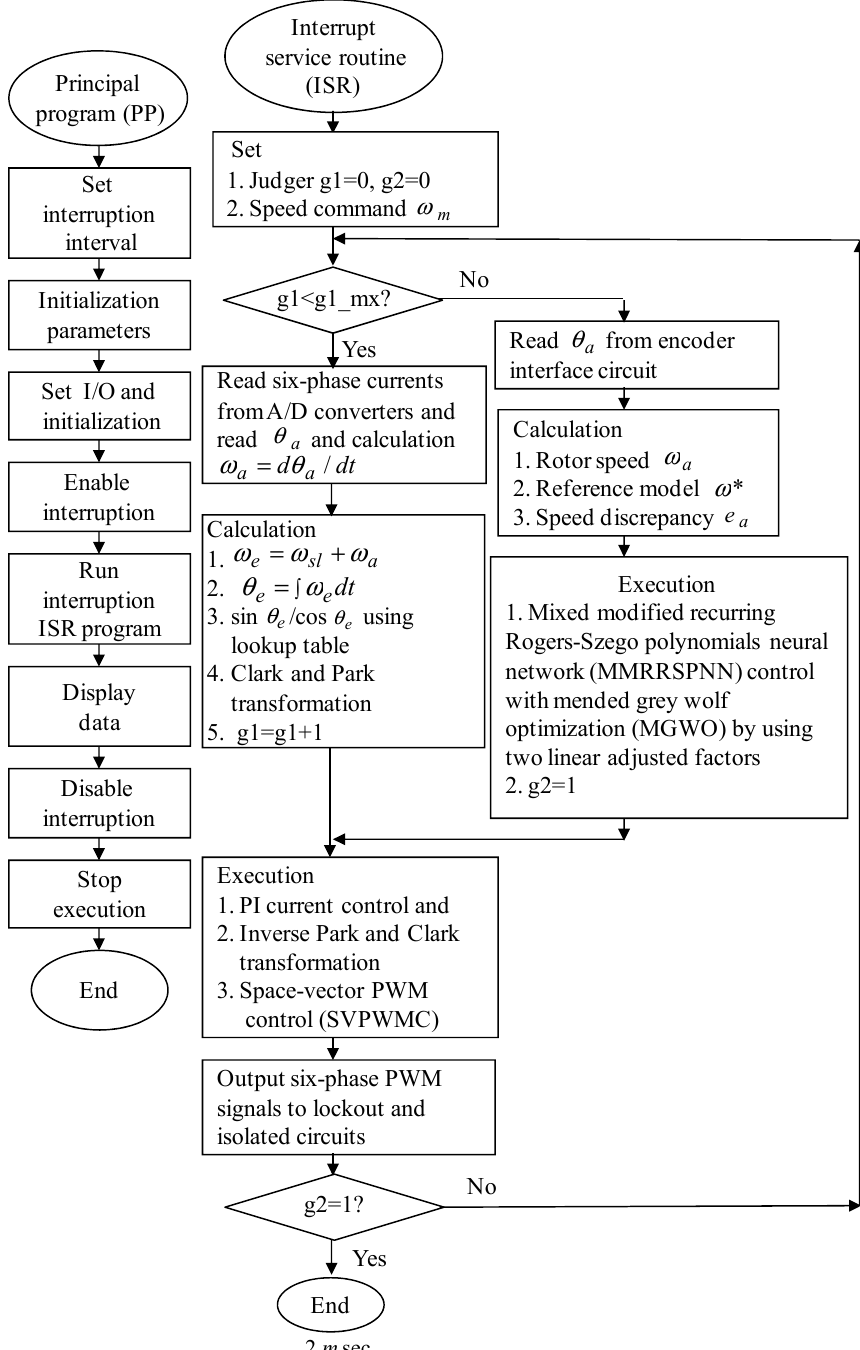
Figure 5. Flowchart of the implemented program by DSP control system.